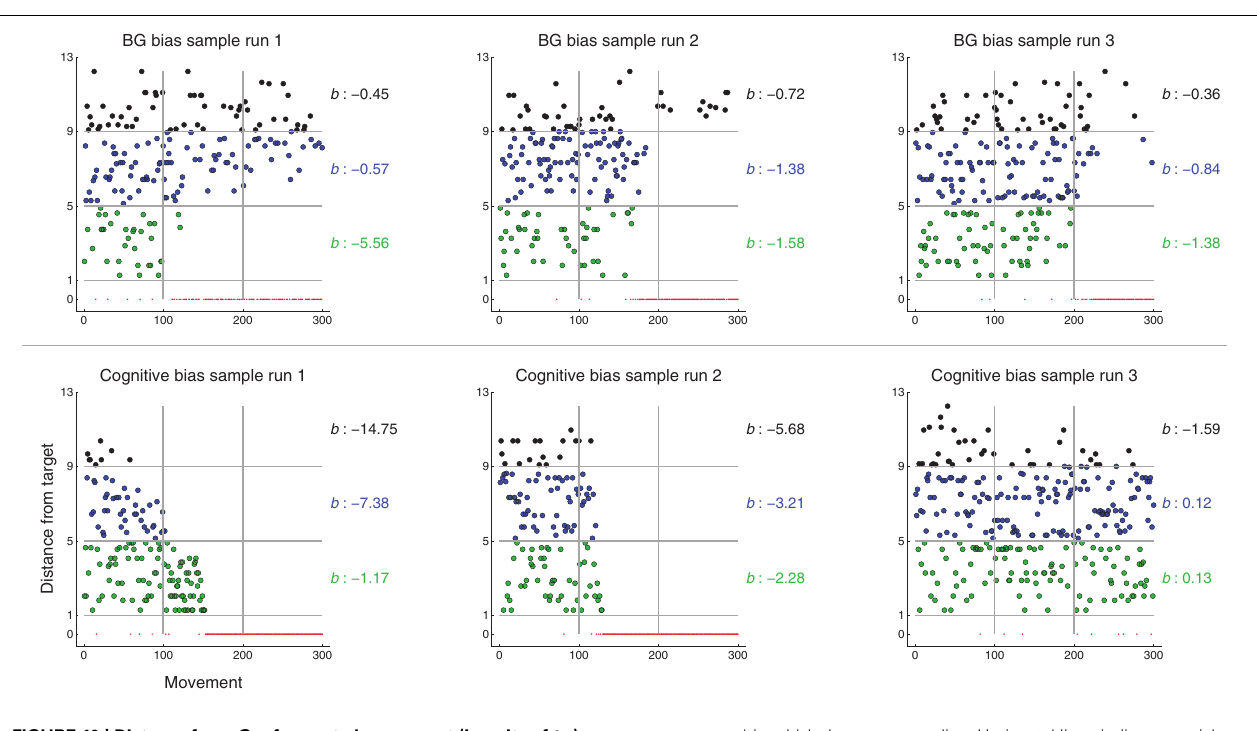
target center) in which the movement lies. Horizontal lines indicate spatial zone borders. Vertical lines indicate temporal chunk borders. The parameter b indicates the rate of decrease of movements falling within each spatial zone. The more negative b is, the greater the rate of decrease (see text for